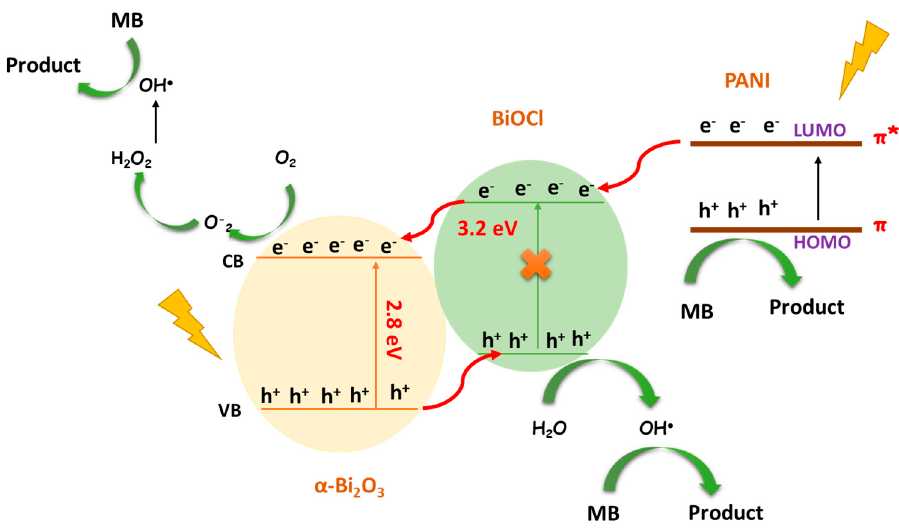
Figure 11. Schematic photocatalytic mechanism of photocatalyst PB composite. E c : semiconductor edge conduction band at 0 charge point, X: absolute electronegativ- ity of semiconductor (Mulliken) (X = 5.95 eV and 5.0 eV for Bi 2 O 3 and BiOCl, respectively), computed from the electronegativity absolute geometric mean of the constituent atoms, defined as the atomic electronic affinity arithmetic means and the energy of the first ioniza- tion. E is the energy of free electrons on the hydrogen scale (~4.5 eV), and E g is the bandgap energy of the